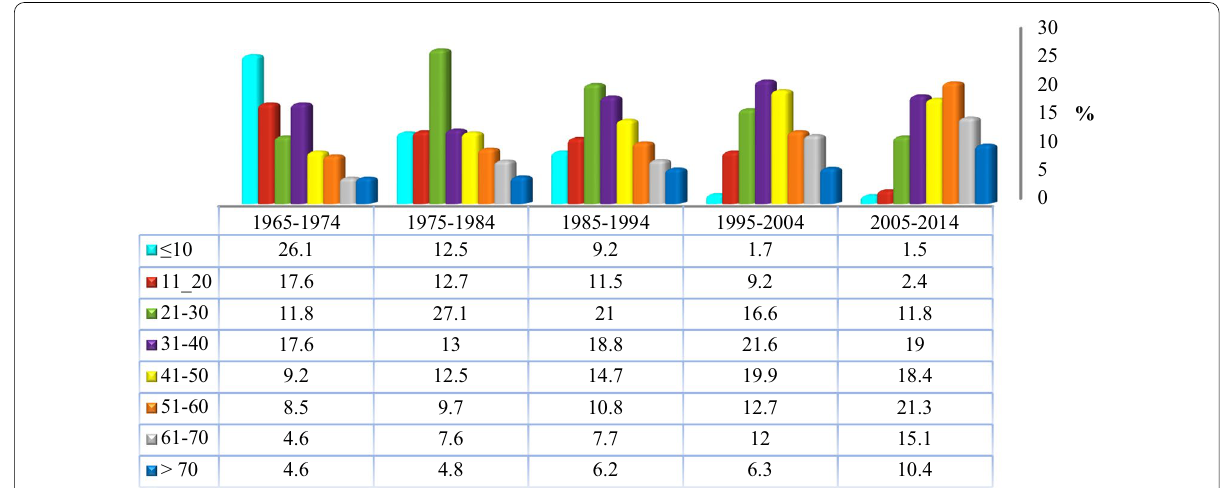
Fig. 3 Distribution of lithiasis of Urology service of the University Hospital center of Oran according to the periods by age group